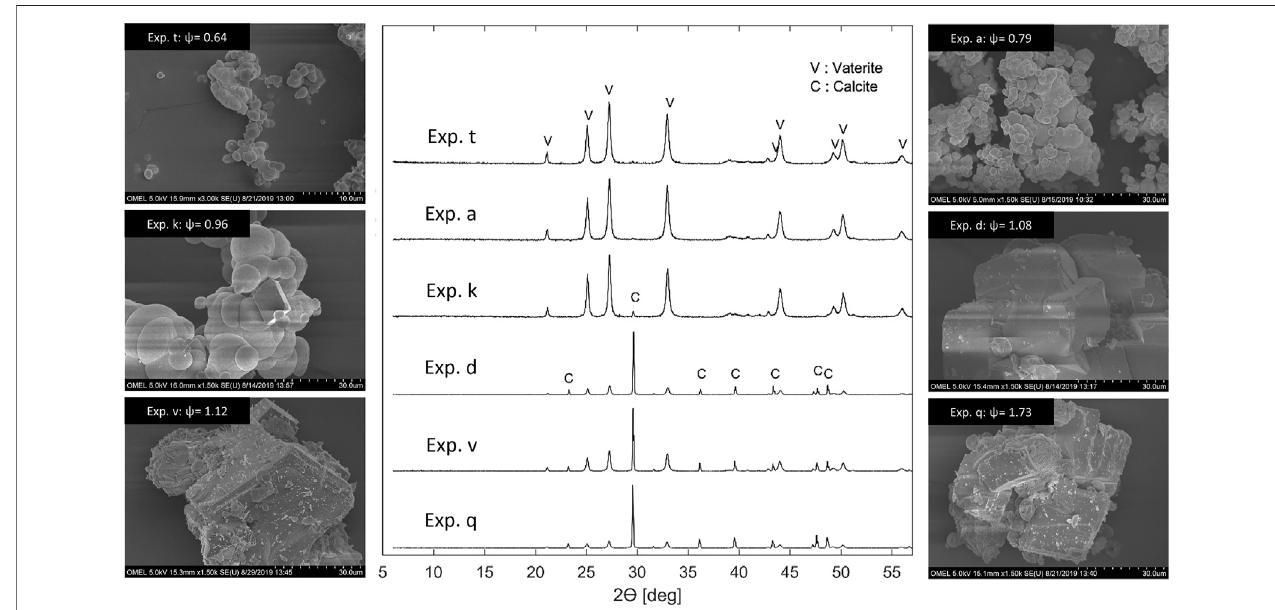
FIGURE7| SelectedXRDpatternsandSEMimagesofprecipitationexperimentsareplottedasafunctionof ψ .Thesphericalparticlescorrespondtovaterite,while the cubes respresent calcite crystals.